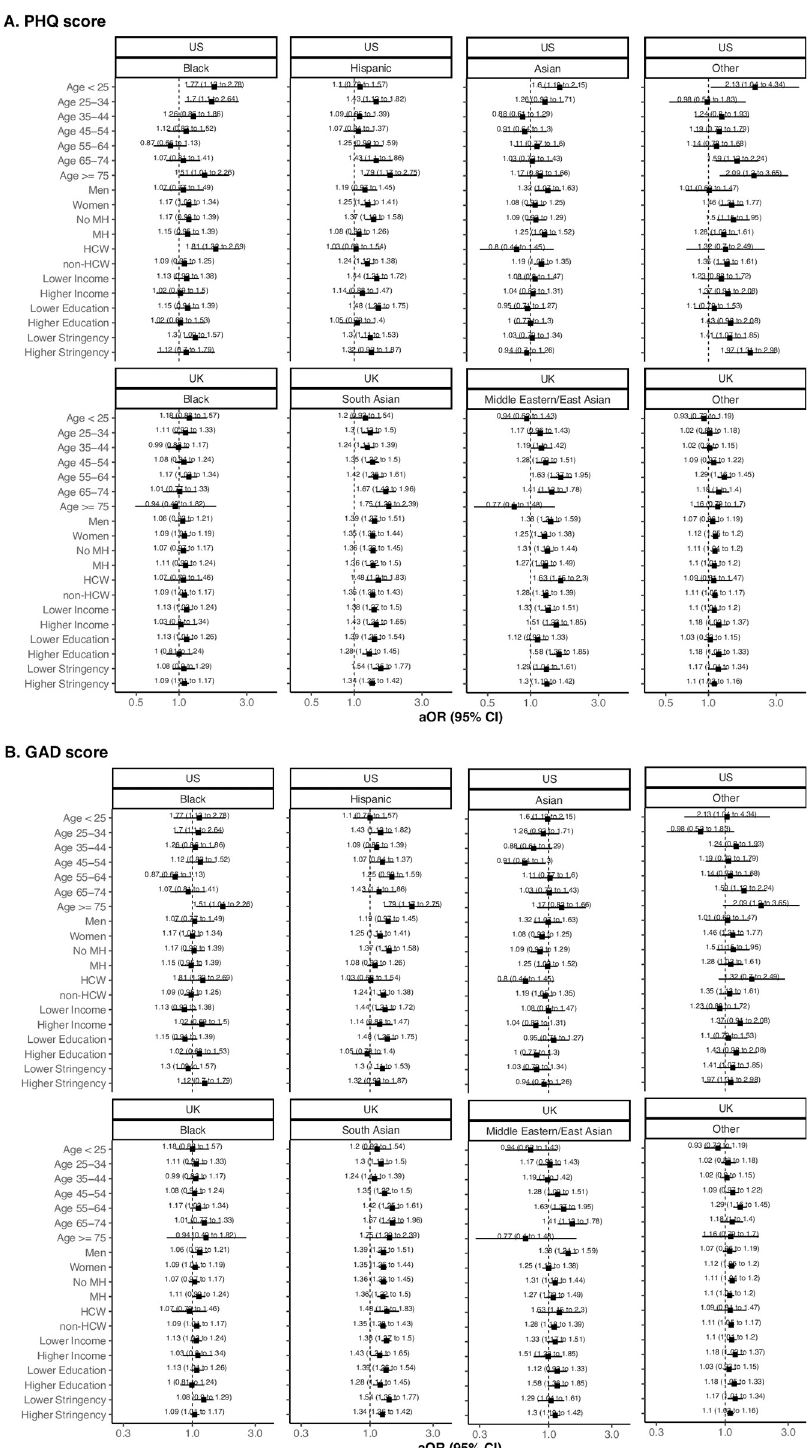
Fig 1. Odds of screening positive for depression or anxiety according to population subgroup. Stratified analyses for A. PHQ and B. GAD scores, respectively, each conditioned upon age, sex, and date of mental health questionnaire completion, and adjusted for personal history of mental health diagnosis, diabetes, heart disease, lung disease, kidney disease, current smoking status, body mass index, prior reported history of COVID-19 infection, HCW status, and community-level education, income, and lockdown stringency except in a given strata. Referent is White individuals of